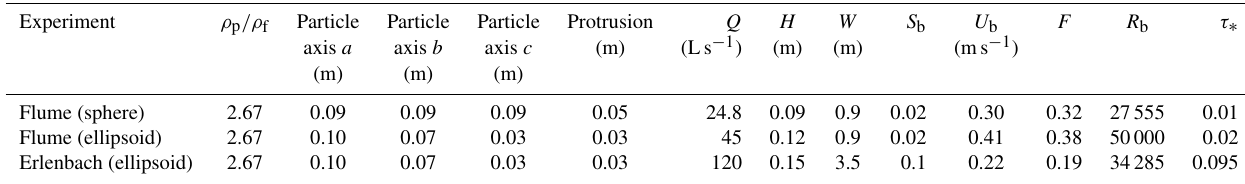
Table D1. The parameters are estimated as follows: ρ p /ρ f is the ratio of an experimental particle density to fluid density ( ρ f = 1000kgm − 3 ), Q is the flow rate at the point of entrainment for the flume experiments and during the transport events in Erlenbach, H is the flow depth (measured from the bottom of the bed to the water surface for Erlenbach and from the top of the hemisphere bed for the flume experiments), U b = Q/A is the bulk mean velocity ( A is the cross-sectional area of the flow), W is the channel width and S b is bed slope. The value 0.105 (or 0.1) is also the average bed slope of the lowermost natural reach in Erlenbach of about 30m length upstream of the stream gauging station. F = U b / ( gd ) 0 . 5 is the Froude number; R b = ( U b d ) /ν is the bulk Reynolds number (where ν is the fluid kinematic viscosity at 0 ◦ C for Erlenbach and at 25 ◦ C for the flume experiments). For the calculations referring to the ellipsoid, we assume D equal to the particle’s b